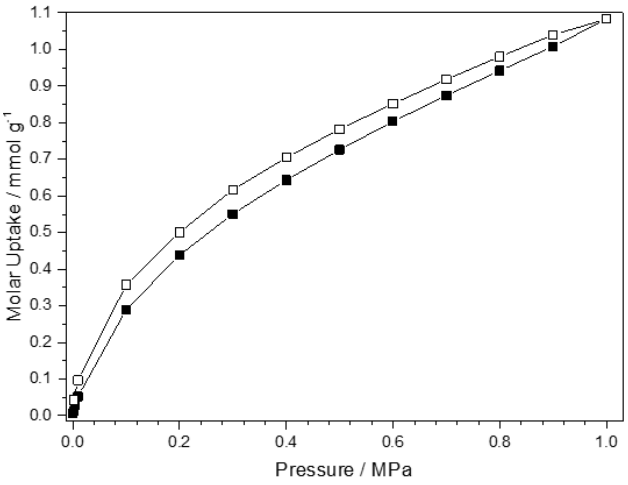
Figure 6. Sorption isotherm for CO 2 on Co-pytz at 273 K.